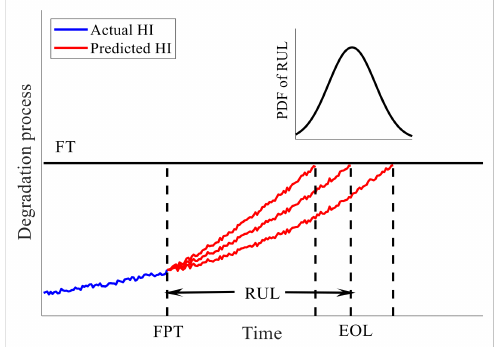
Figure 6. RUL prediction